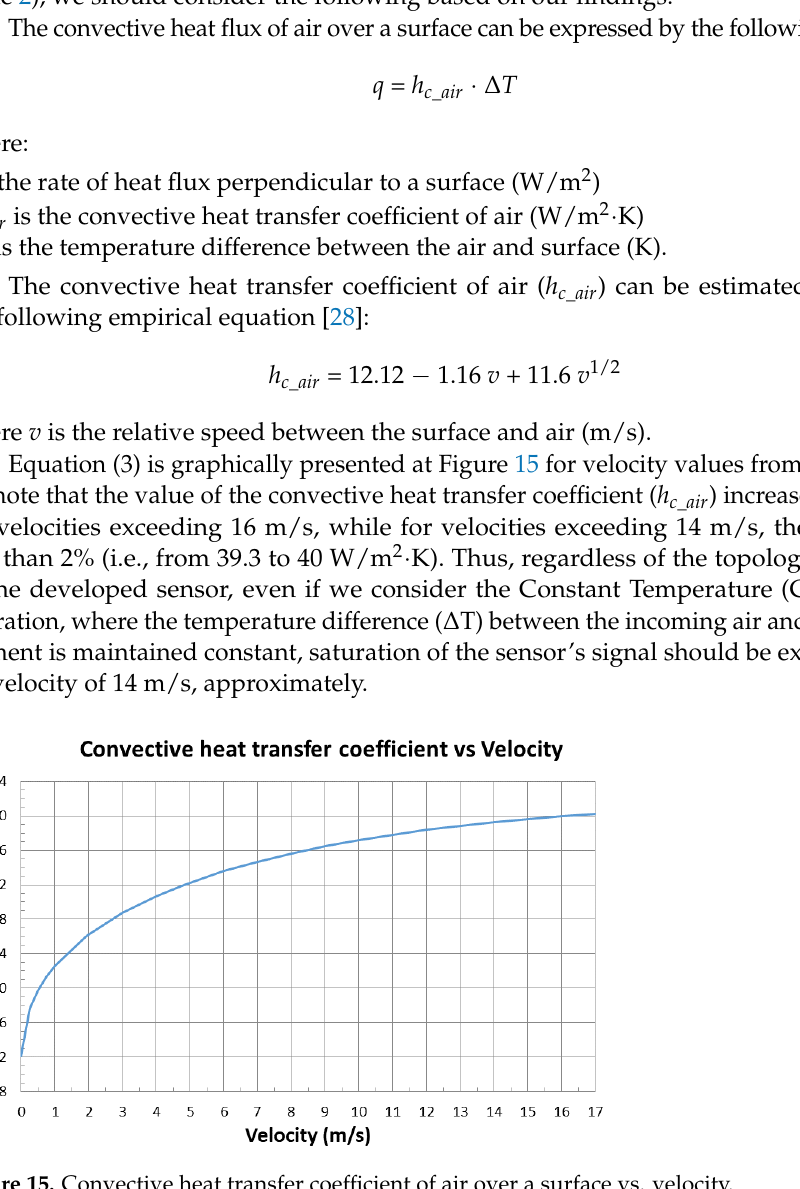
Figure 15. Convective heat transfer coefficient of air over a surface vs. velocity.